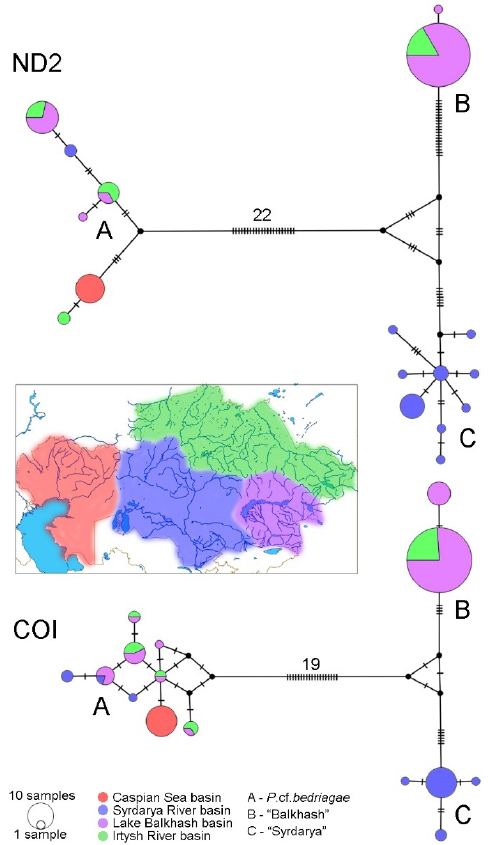
Figure 2. Bayesian phylogenetic tree of mtDNA (ND2 + COI genes), abbreviation of MHG (mito- chondrial haplogroups) is in accordance with the data published by Akin et al., 2010. Posterior probabilities less than 0.70 are not shown.